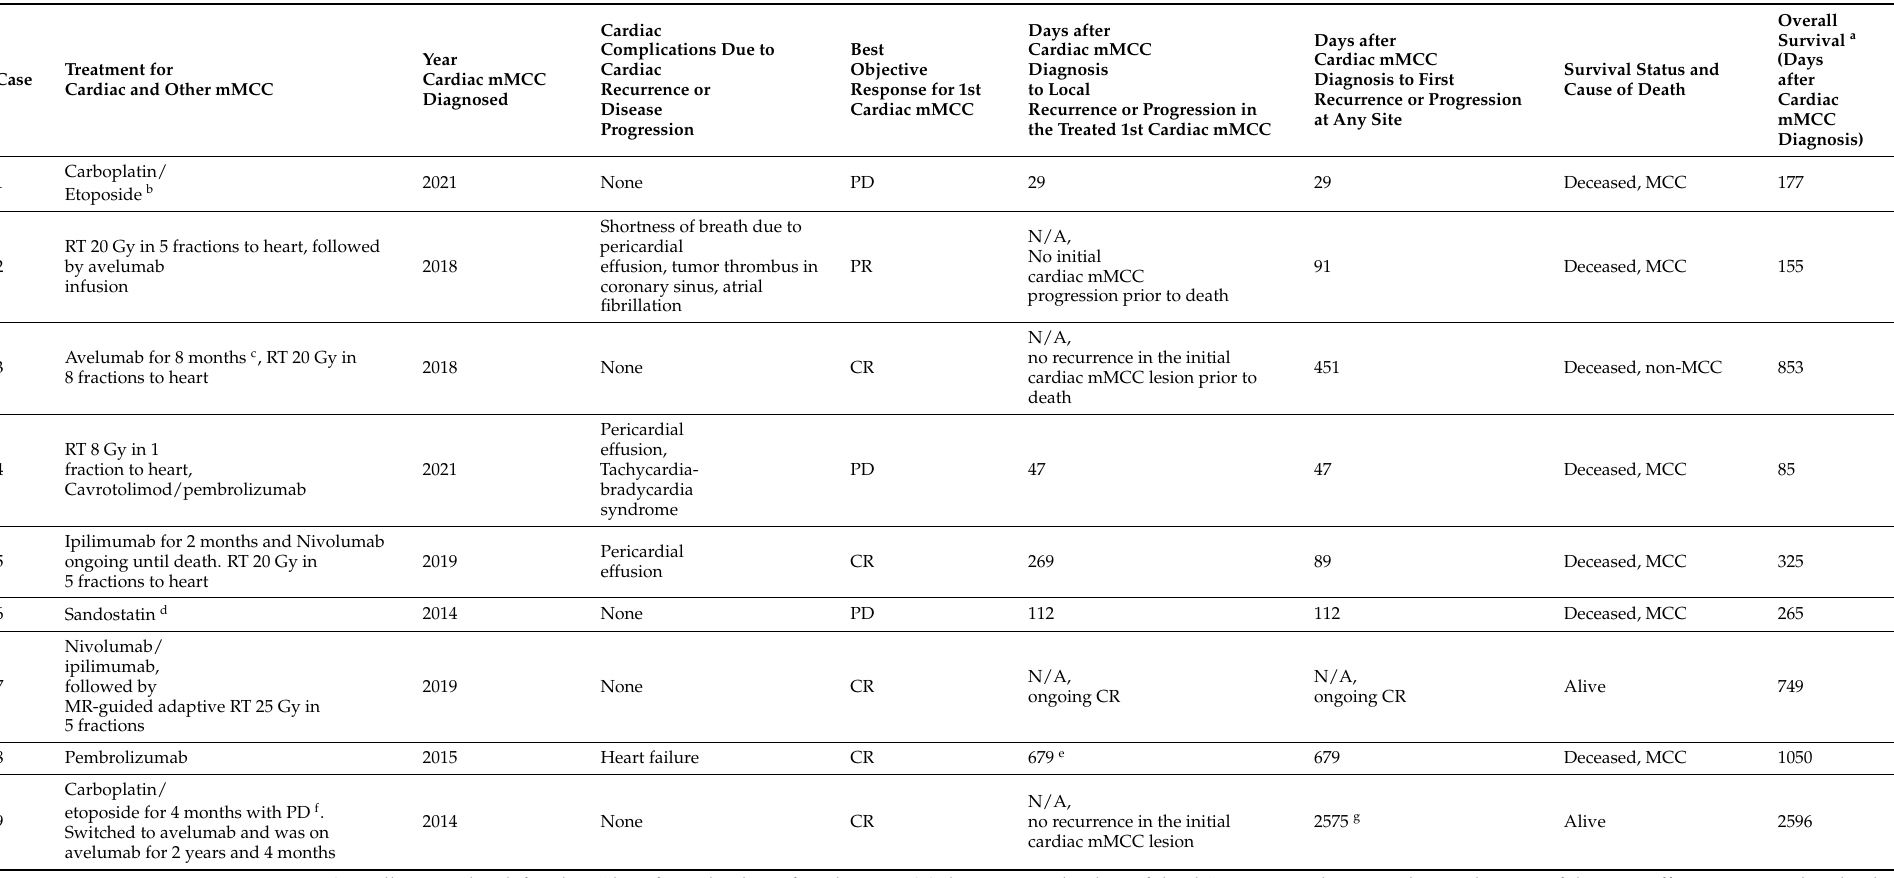
Table 3. Summary of treatment for cardiac mMCC and